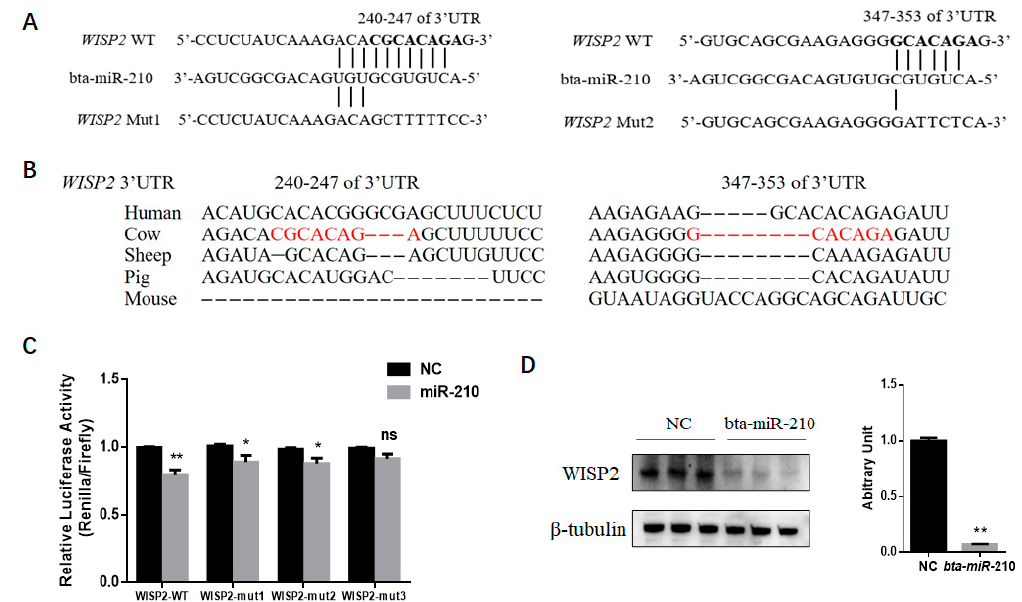
Figure 5. miR-210 regulates the adipogenic differentiation of PDGFR α + cells by inhibiting WISP2 . ( A ) Sequence alignments of predicted miR-210 target sites in wild-type and mutant WISP2 3 ′ -UTRs. ( B ) Both predicted miR-210 binding sites are not conserved among mammals. ( C ) Luciferase reporter activity of various reporter constructs in cells co-transfected with either miR-210 mimics or NC. Renilla luciferase activity was normalized to that of firefly luciferase. ( D ) Representative Western blot results showing WISP2 expression in PDGFR α + cells treated with NC or miR-210 mimics; the grayscale intensity was quantified. All the measurements shown are the means ± SEM of three biological replicates from independent cell experiments. NC, negative control. * p < 0.05; ** p < 0.01.